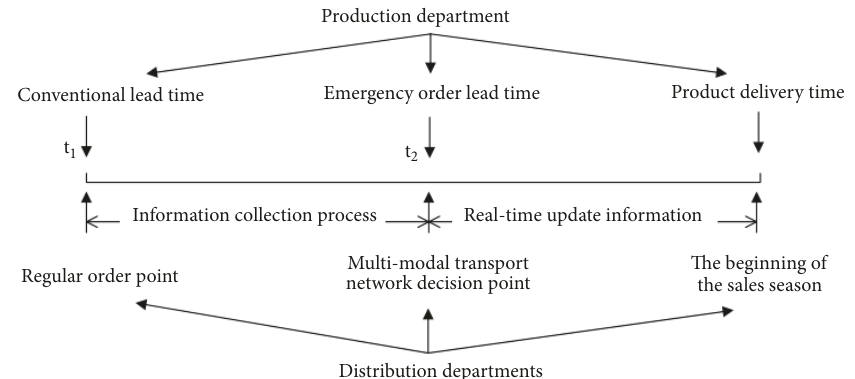
Figure 1: Ordering decision point